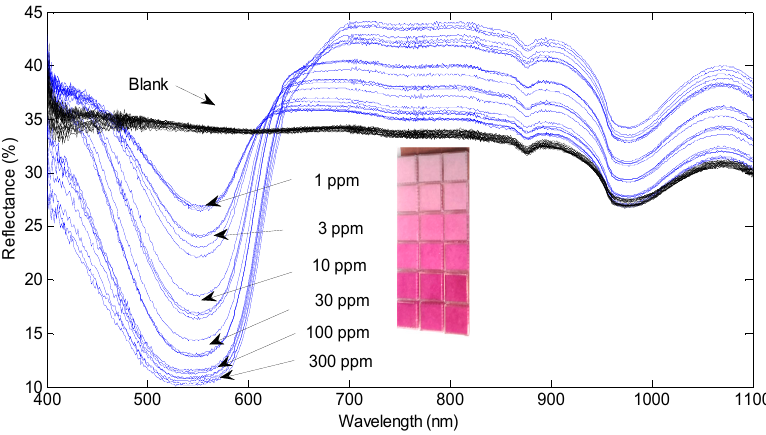
Figure 1. Spectral response of the gas-sensitive pads upon exposure to increasing concentrations of NO 2 . Insets show real pictures of the color of the sensing pads in each one of the